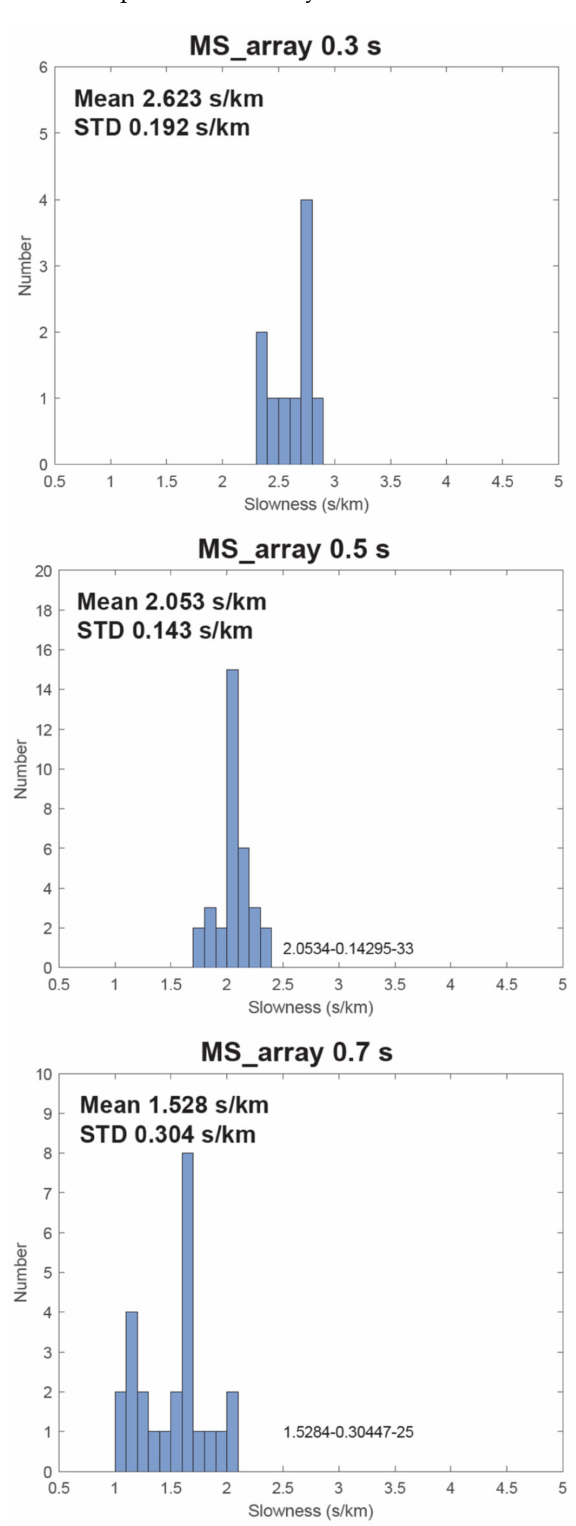
Figure 4. Histograms of repeated measurements of the slowness at Station MS22 at periods of 0.3 s, 0.5 s, and 0.7